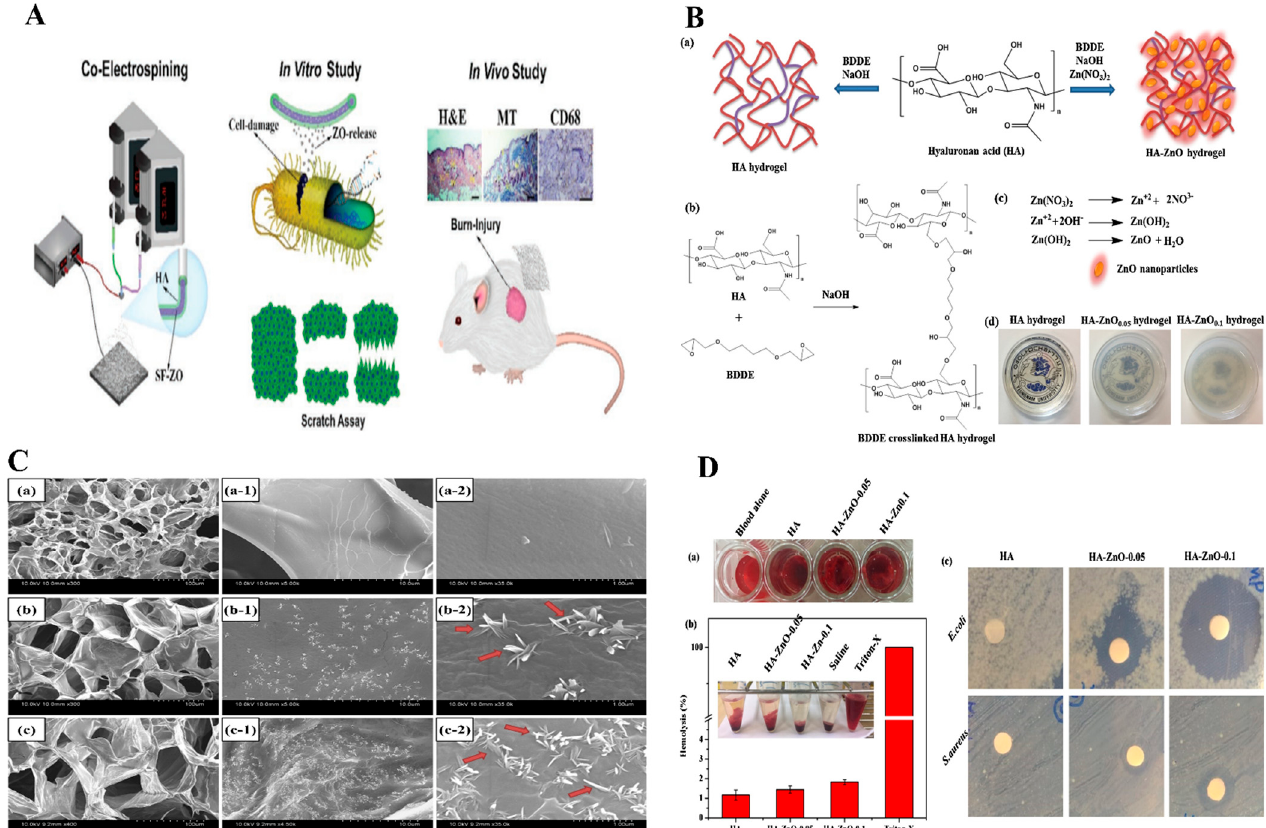
Figure 5. ( A ) Preparation of antibacterial HA-SF/ZnO fibers with core-shell structure and applied for wound healing. Copy right 2020, John Wiley and Sons [106]. ( B ) Formation of HA and HA-ZnO hydrogels, ( C ). SEM images ZnO hydrogels. ( D ). Hemolysis and antibacterial activity of hydrogels Figure ( B – D ) Copyright 2019, Elsevier [113]. ( B ) HA and HA-ZnO hydrogels B ( a ) formation